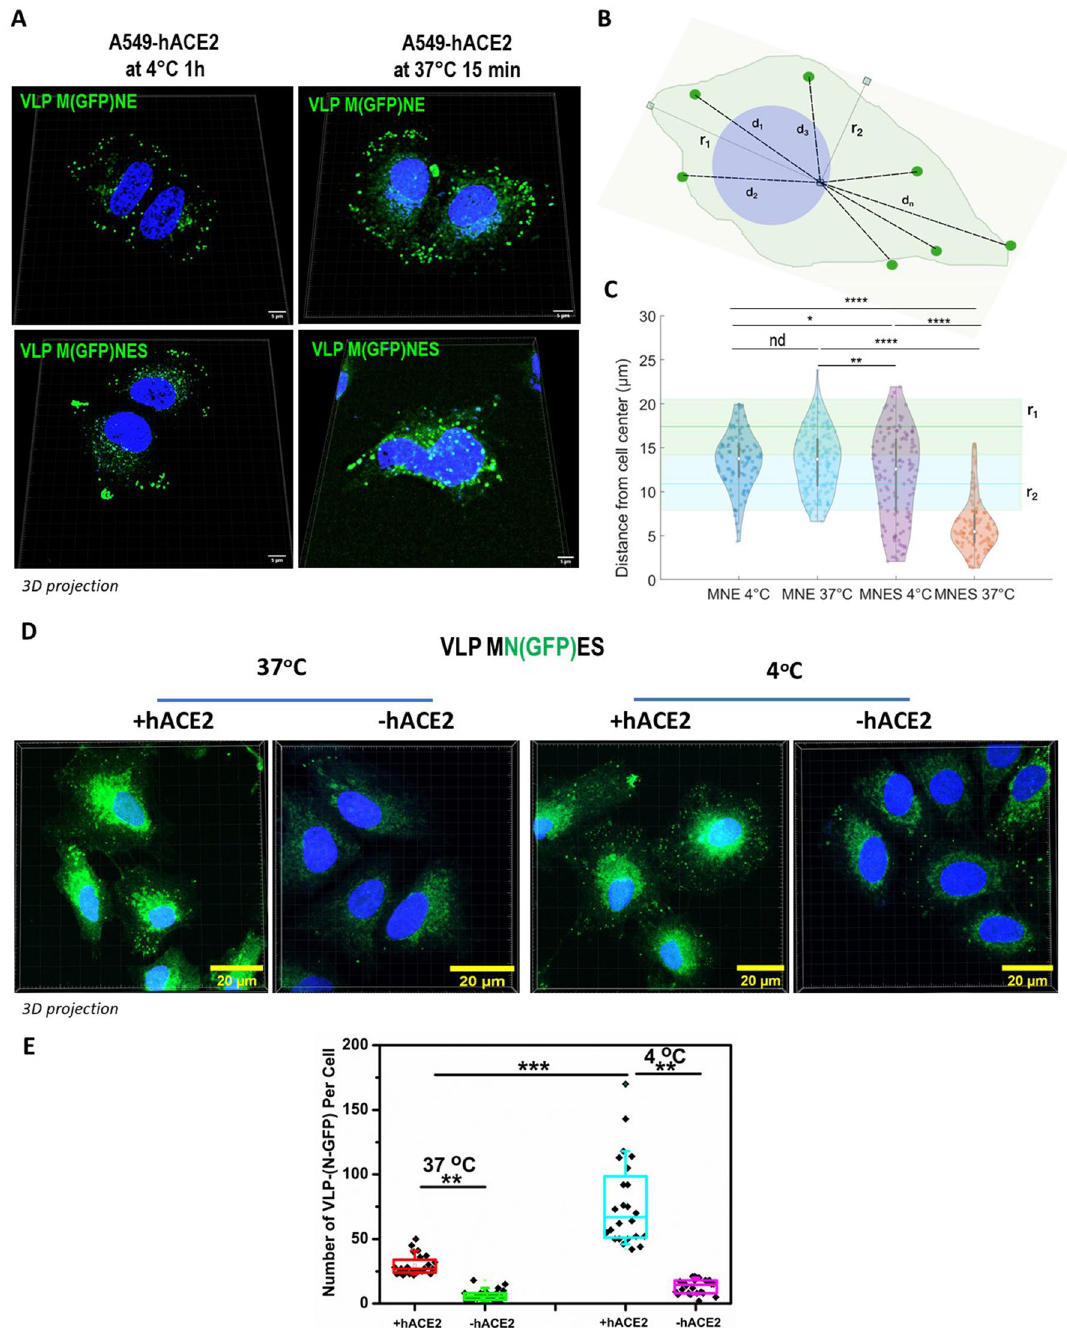
Figure 5. Internalization of VLPs-(GFP) with and without Spike on A549 pulmonary cells expressing or not hACE2 using confocal fluorescence microscopy. ( A ) M(GFP)NE ± S VLPs were incubated on A549-hACE2 cells at 37 °C for 15 min or at 4 °C for 1 h. Nuclei were stained with DAPI. ( B ) Schematic of distance measurement and cell center determination from minor and major axis of the cell. Scheme was drawn with the help of Inkscape. ( C ) Violin plot of the distribution of the VLP-cell center distances for the different conditions (MNE vs MNES at 4 °C and 37 °C respectively). The average value and the standard deviation of the major and minor axis (r 1 and r 2 ) observed in the different cell conditions (n = 16 cells) are respectively plotted as green and blue lines (mean) surrounded by rectangle (sd). All the conditions except MNES at 37 °C have distances mean values lying between these two limit axis values. *p-value < 0.05; **p < 0.01; ****p < 1.e10 –15 ; nd non significative. ( D ) Confocal images of MN(GFP)ES VLPs (in green) on A549 or A549-hACE2 cells incubated at 37 °C or at 4 °C show the internalization of VLPs. MN(GFP)ES VLPs were incubated on cells at 37 °C for 15 min or at 4 °C for 1 h. Nuclei were stained with DAPI (in blue). The scale bar is 20 µm. ( E ) Quantification of the number of MN(GFP)ES VLPs per cell in each condition, in the presence and the absence of the receptor hACE2 (+ or − hACE2) and at 4 °C (partially blocked endocytosis) or 37 °C (activate endocytosis and fusion). N = 2, 24 cells analyzed per condition. **p < 0.01; ***p <